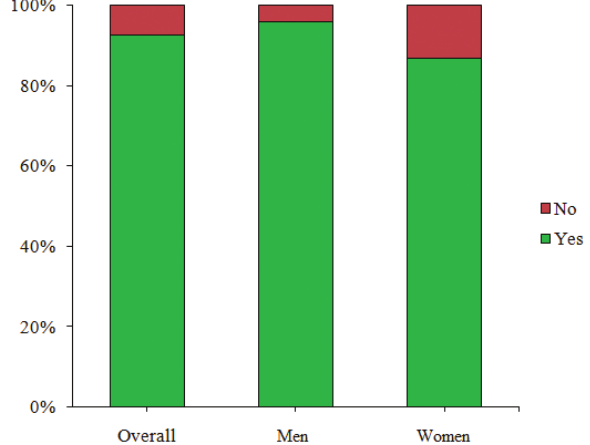
Figure 4. Cumulative and gender-wise responses to K2: “Do you know that Bangladesh government is working towards im - plementing the country’s first NPP named as Rooppur NPP?”.